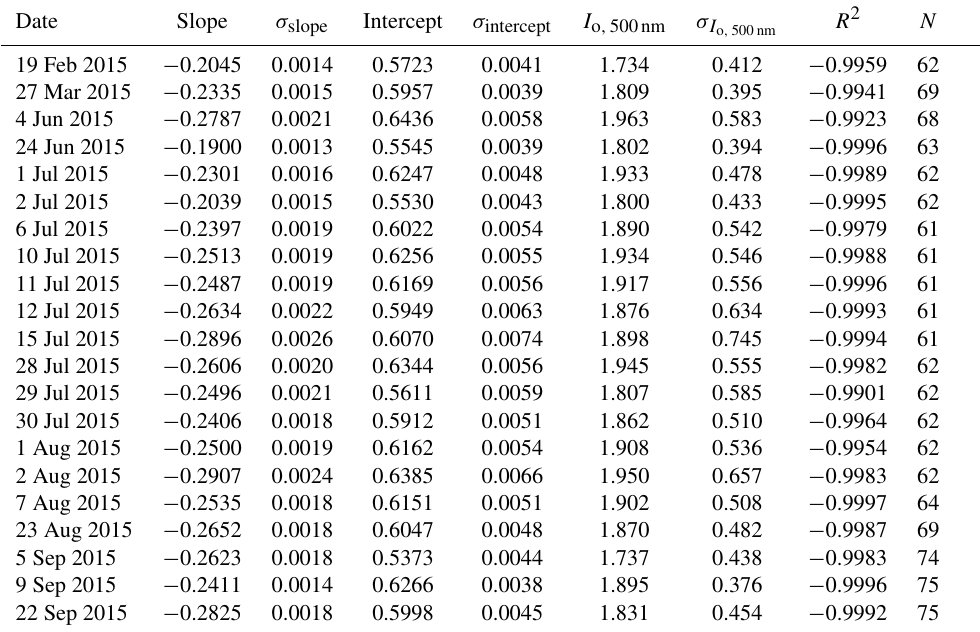
Table 2. Individual extraterrestrial calibration results ( I o , 500nm ) applying the Langley plot technique to measurements of solar direct normal irradiance at 500nm from a MFRSR operating at the T0e site in central Amazonia for 2015. The individual uncertainty ( σ I to obtain the relative error ( σ I (%)) was estimated from the intercept and its respective uncertainty ( σ intercept ) derived from the least- o , 500nm square regression